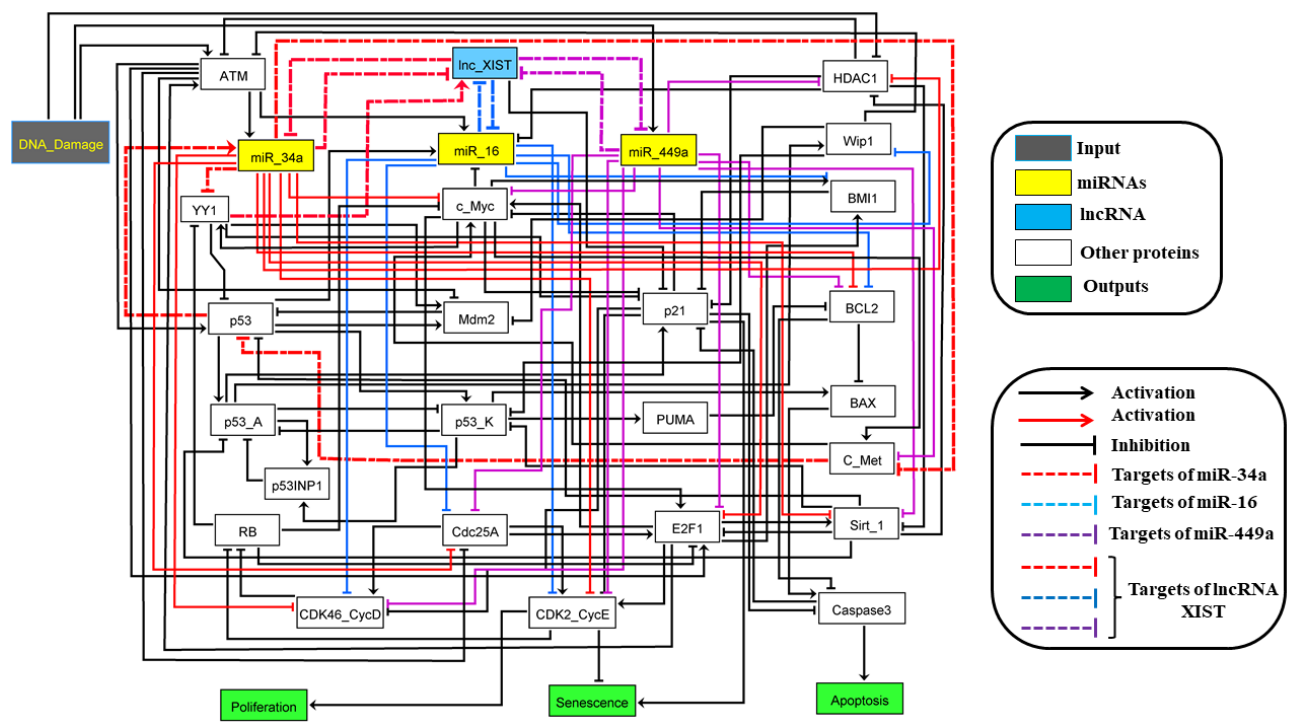
Figure 1. Boolean model for the regulation of the G1/S checkpoint in response to DNA damage in NSCLC. miR-34a, miR-16, miR-449a in yellow rectangle, while lncRNA XIST is in the blue rectangle. Dark edges denote activations and red hammerhead edges denote the inhibition by miR-34a of its targets. Blue hammerhead edges denote the inhibition by miR-16 of its targets and violet hammerhead edgesdenote the inhibition by miR-449a. MiR-34a and miR-449a, directly target c-Myc, HDAC1, Sirt-1, E2F1, Cdc25A, BCL2, CDK4/6-cyclin D1 complex (cdk4,6-CycD) and CDK2-cyclin E2